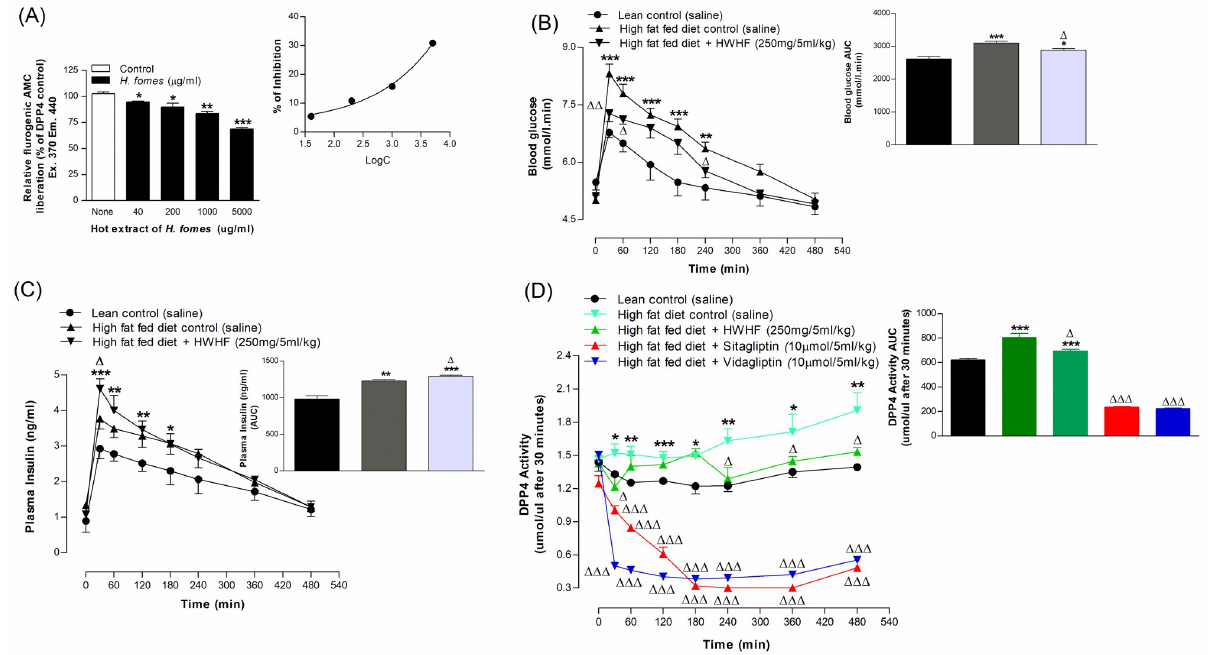
Fig 3. Acute effects of HWHF on (A) DPP-IV enzyme activity in vitro , (B) glucose tolerance, (C) plasma insulin and (D) plasma DPP-IV in high fat fed rats. Parameters were assessed before and after oral administration of 18 mmol glucose/kg, body weight (control) with or without HWHF (250 mg/5ml/kg, b.w.). Established DPP-IV inhibitors: sitagliptin and vildagliptin, were used as positive controls. Values are Mean ± SEM, n = 4 for DPP-IV enzyme activity in vitro and n = 6 for glucose tolerance, plasma insulin and DPP-IV in vivo . � p < 0.05, �� p < 0.01 and ��� p < 0.001, compared to normal control and Δ p < 0.05, ΔΔ p < 0.01 and ΔΔΔ p < 0.001 compared to